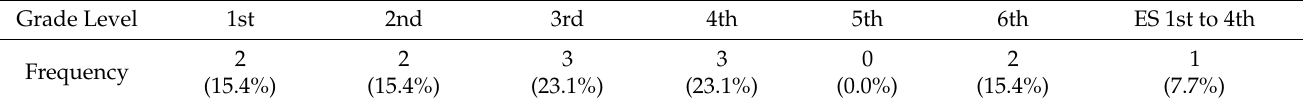
Table 3. Distribution of the teachers by the grade level they teach (ES—Educational